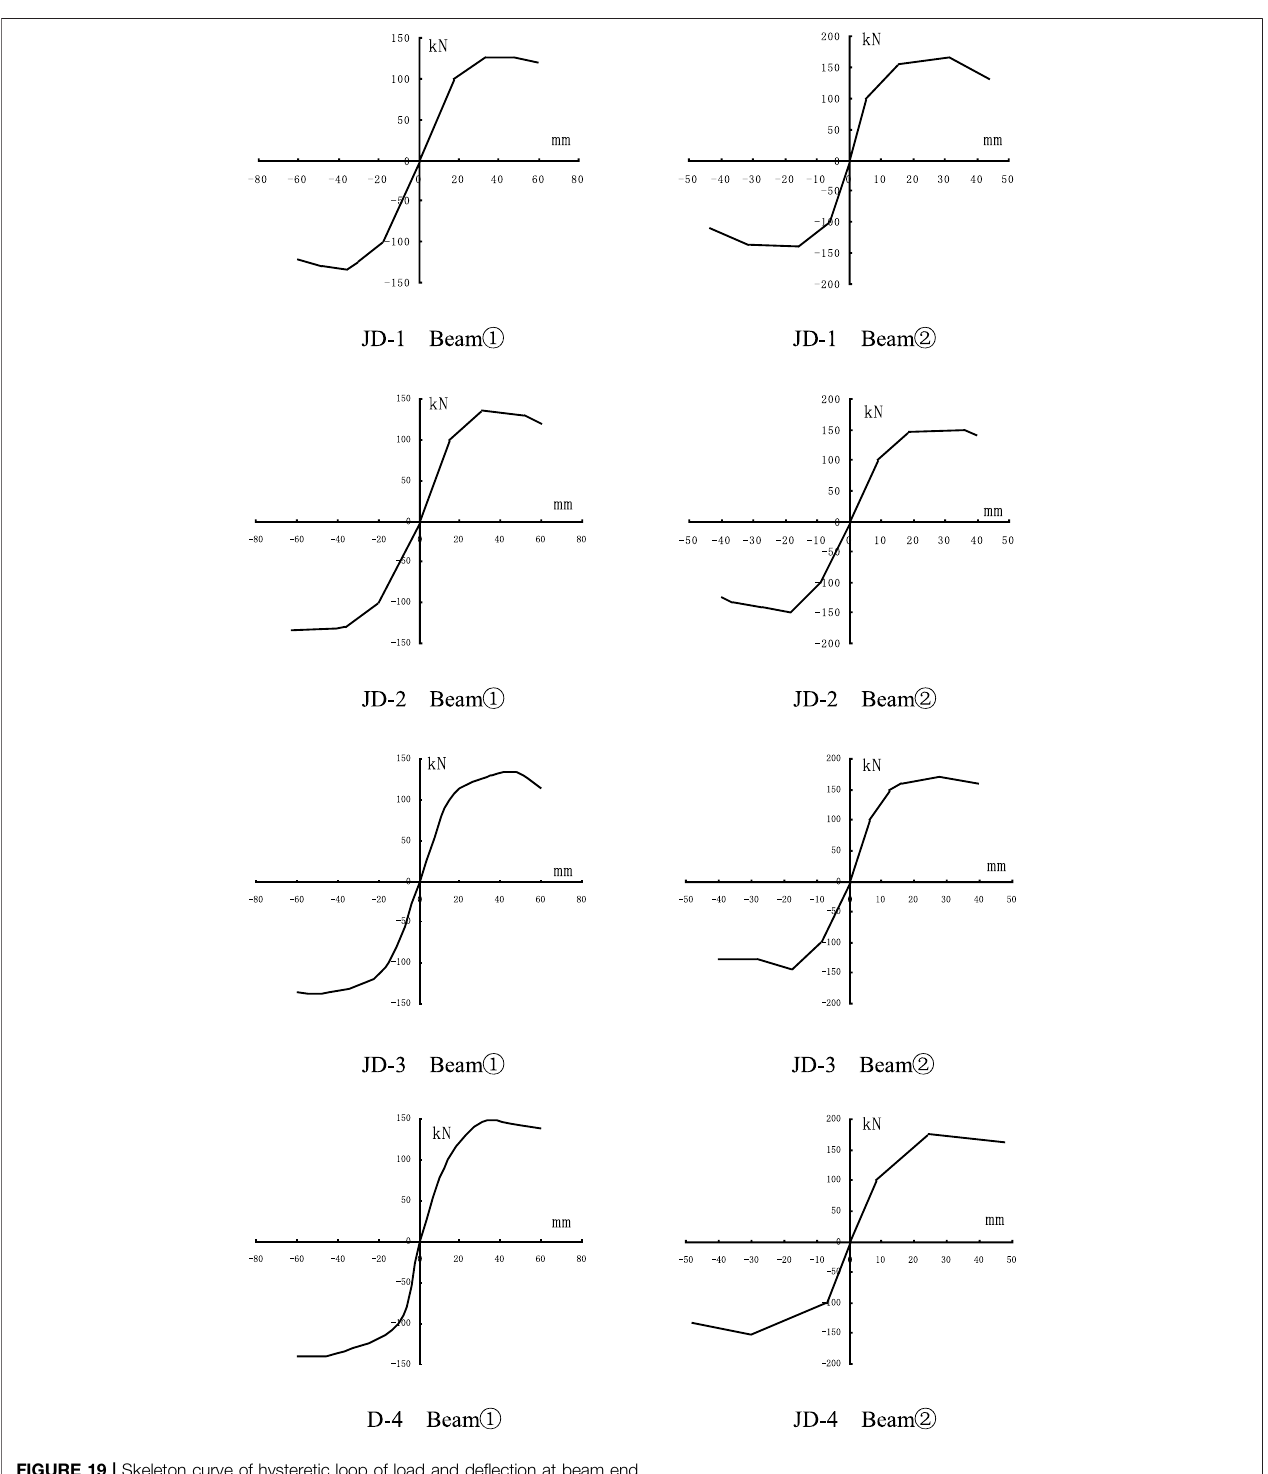
Frontiers in Materials |